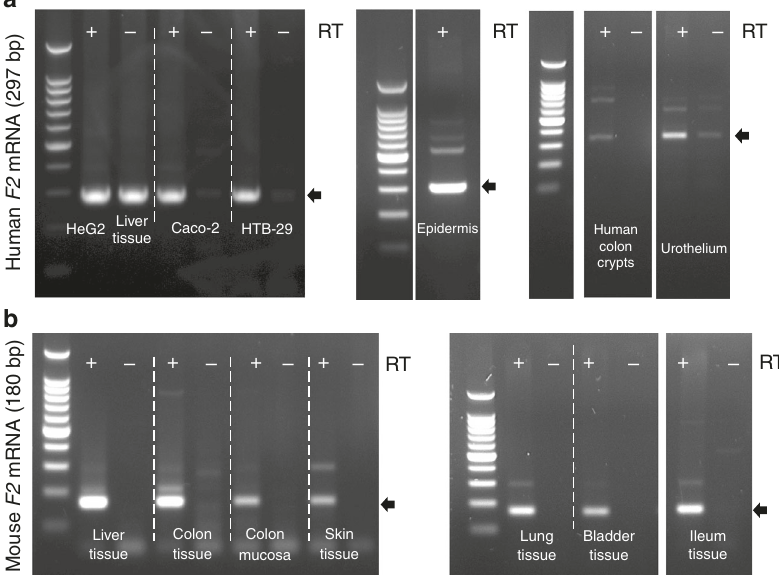
Fig. 6 The F2 gene encoding thrombin is expressed in all major epithelia under healthy conditions. F2 mRNA transcript (thrombin) was detected by